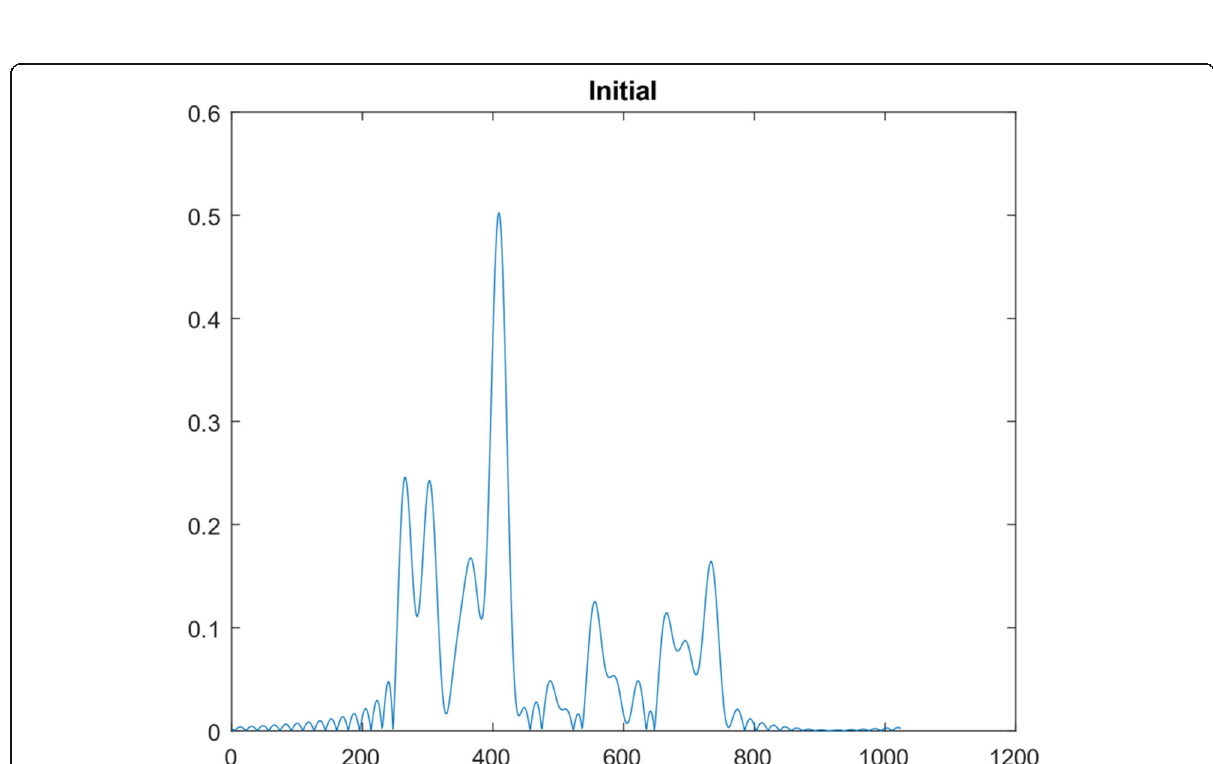
Fig. 7 The spatial-domain function obtained from the lowest 30 frequency components of the ‘ random ’